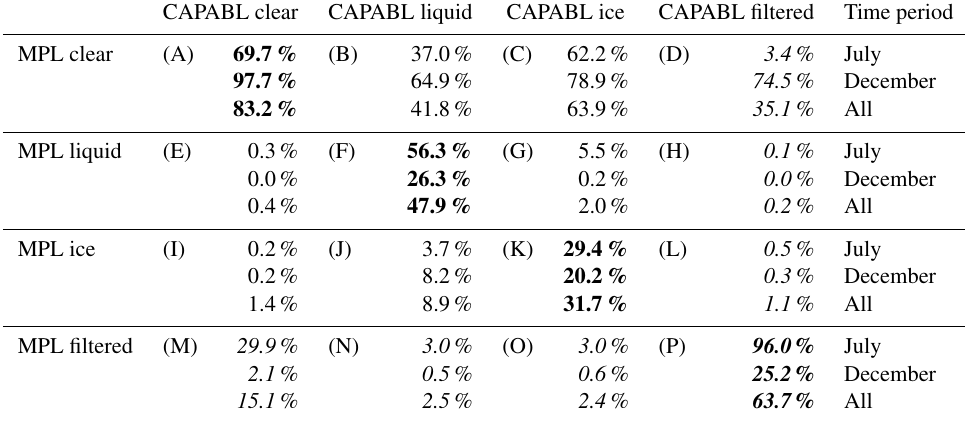
Table 5. Confusion matrix of CAPABL and MPL processed data. The diagonal shows agreement, highlighted by bold text. The last row and last column indicate one instrument had data removed by quality control steps, also highlighted in italics. Cells B and C indicate enhanced sensitivity by CAPABL processing and cells E and I indicate enhanced sensitivity by the MPL processing. Cell P indicates both instruments lack data, implying that much of the data missed are in a regime not reachable via lidar (i.e., large optical depth). Three sets of data are given in each cell, which are identified by the last column. The first line of each cell covers the time period 1–31 July 2016. The second line